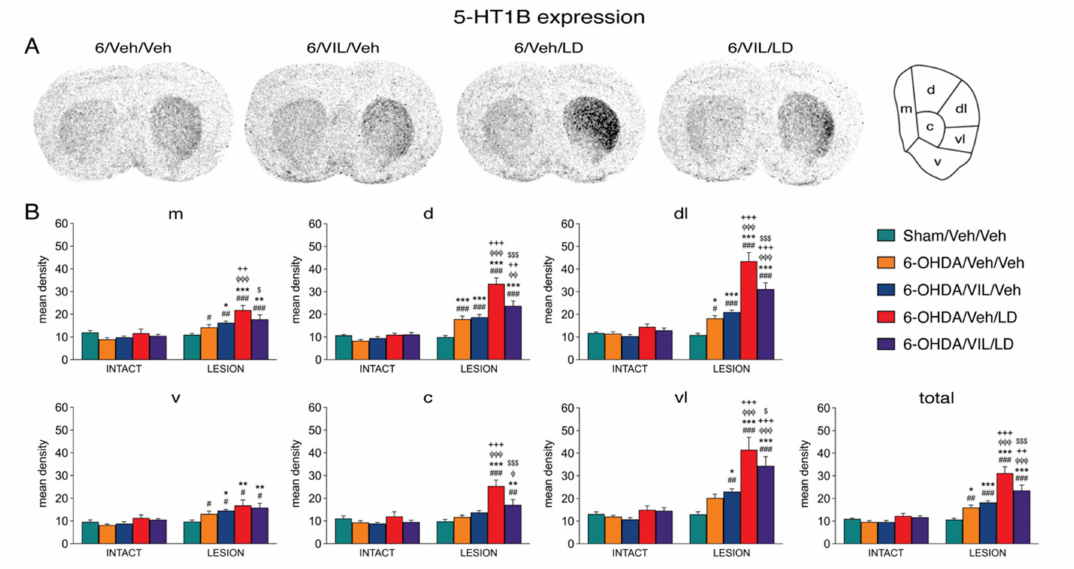
Figure 3. Vilazodone did not alter striatal enkephalin expression after L-DOPA treatment. ( A )Illustrationsoffilmautoradiogramsdepicttheexpressionofenkephalininsectionsfromthemid-level striatum after a 6-OHDA lesion (right hemisphere) followed by repeated vehicle (6-OHDA / Veh / Veh), vilazodone (10 mg / kg) + vehicle (6-OHDA / VIL / Veh), vehicle + L-DOPA (5 mg / kg) (6-OHDA / Veh / LD), or vilazodone + L-DOPA treatment (6-OHDA / VIL / LD). Animals were killed 60 min after the L-DOPA injection. ( B ) Mean density values (mean ± SEM) for enkephalin expression in the mid-level striatum on the intact side or the side of the lesion in the sham lesion controls (Sham / Veh / Veh) and the 6-OHDA / Veh / Veh, 6-OHDA / VIL / Veh, 6-OHDA / Veh / LD, and 6-OHDA / VIL / LD groups. Gene expression was measured in six sectors and the total middle striatum (upper right). m, medial; d, dorsal; dl, dorsolateral; vl, ventrolateral; c, central; v, ventral. ## p < 0.01, ### p < 0.001 vs. same group on the intact side; ** p < 0.01, *** p < 0.001 vs. Sham / Veh / Veh; ϕ p < 0.05 vs. 6-OHDA / Veh / Veh.